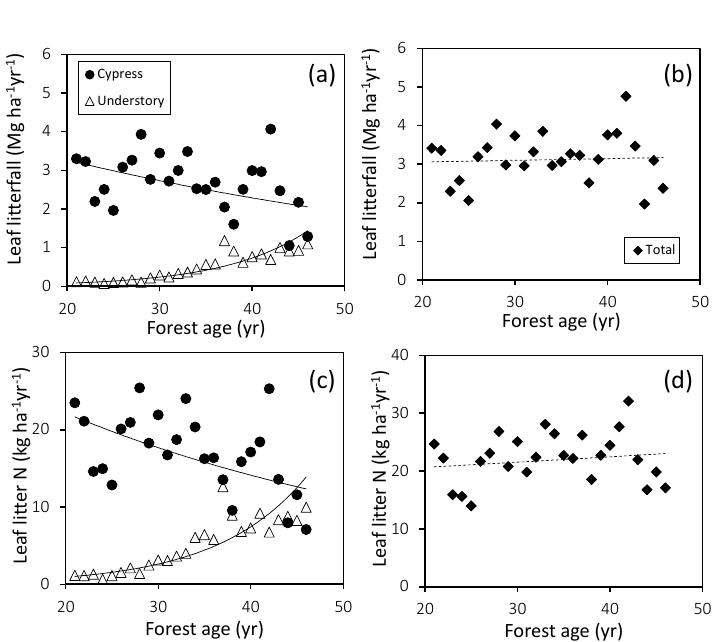
Figure 2. Leaf litterfall of hinoki cypress and understory vegetation ( a , b ) and litter nitrogen input of hinoki cypress and understory vegetation ( c , d ) in relation to forest age. Table 3. Stem and leaf properties of hinoki cypress trees in the study site.